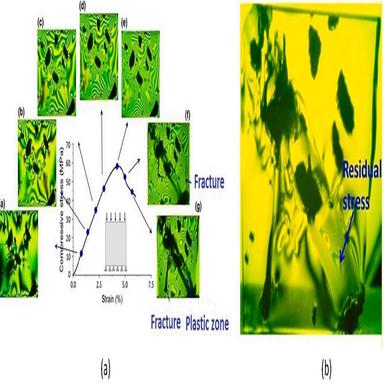
(a) Evolution of plastic zones and fracture initiation at different stress levels and (b) the residual stress distribution . The copyright permission for this figure has been granted.